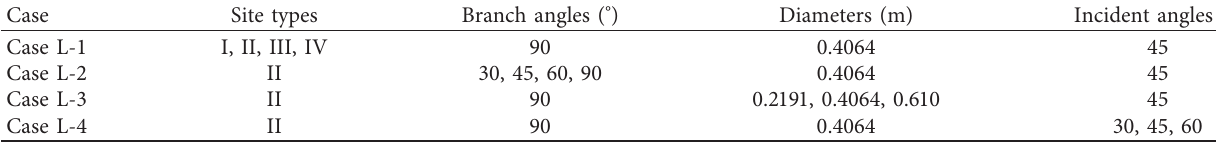
Table 15: Parameters of L-shaped connection in different cases.